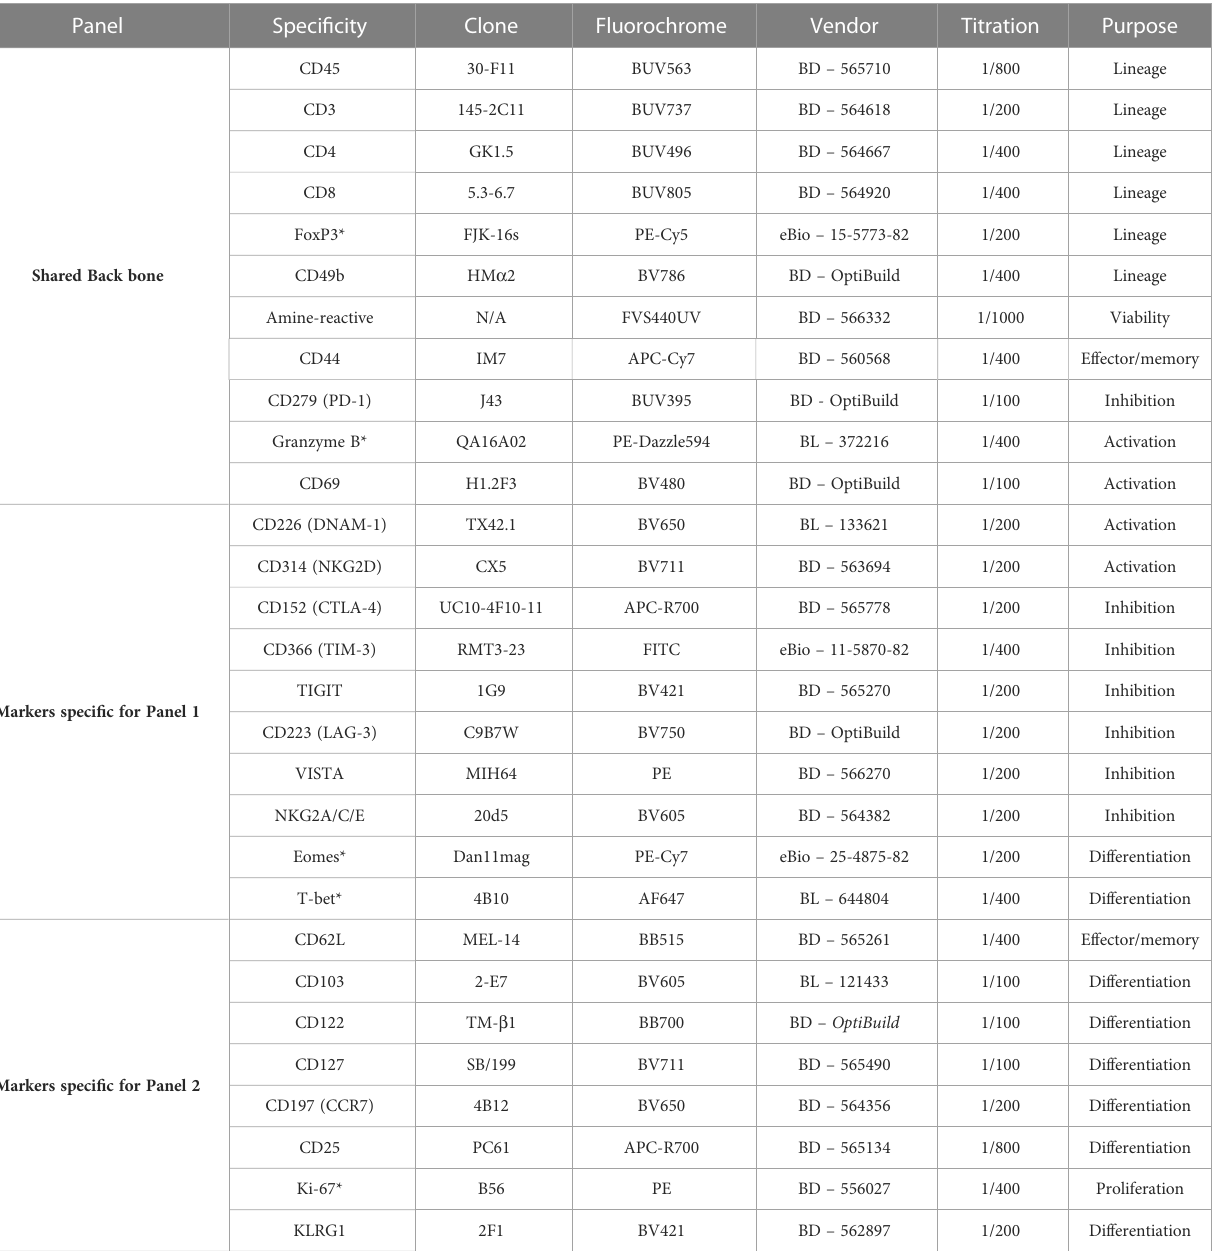
TABLE 3 List of antibodies and relative fl uorochromes used in Panels 1 & 2